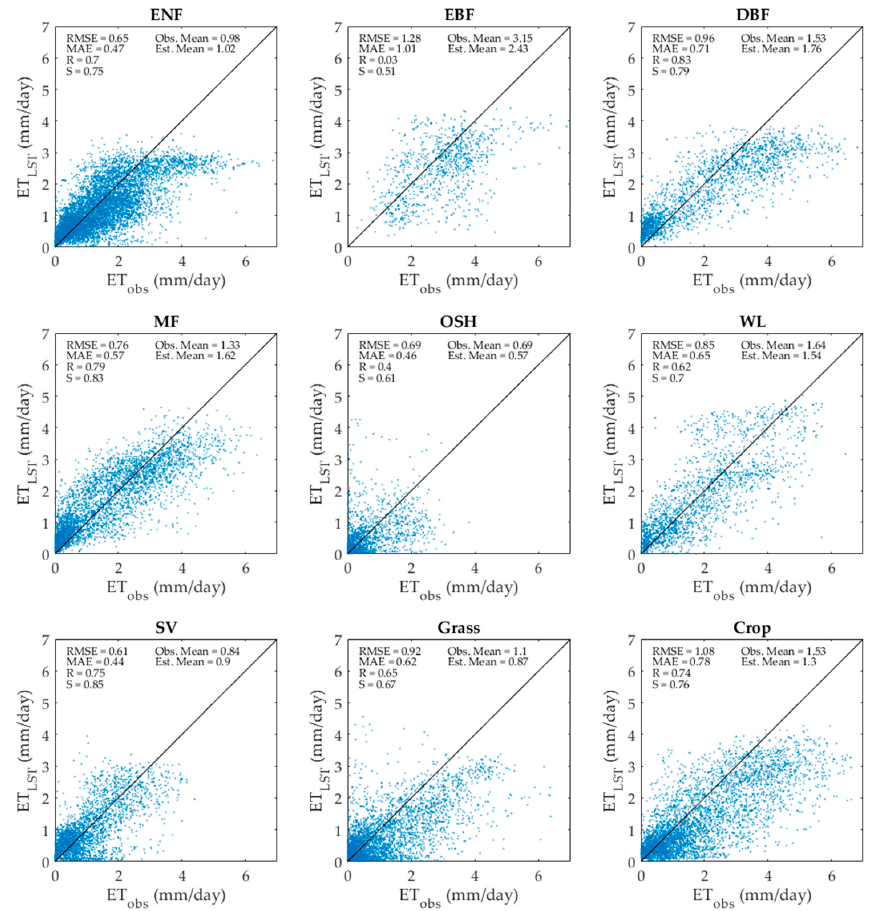
Figure 8. Comparison between daily ET obs and ET LST along with mean ET obs and ET LST and error measures for all the AmeriFlux sites used in this study over the period of 2000–2006 categorized into different land covers.